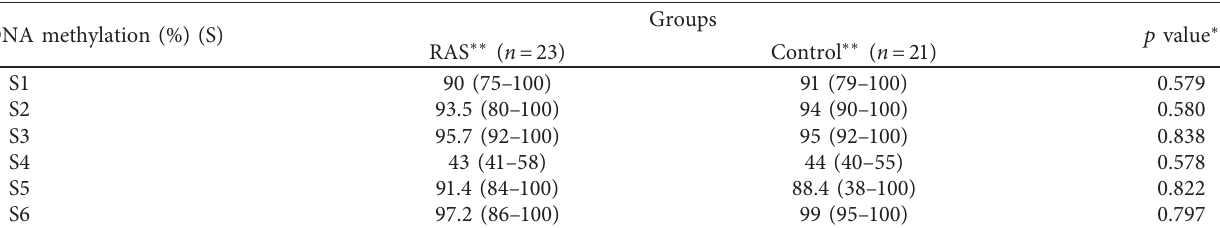
Figure 3: (a) Percentage of methylation in CpG site 1. (b) Percentage of methylation in CpG site 2. (c) Percentage of methylation in CpG site 3. (d) Percentage of methylation in CpG site 4. (e) Percentage of methylation in CpG site 5. (f) Percentage of methylation in CpG site 6. (g) Pyrosequencing of DNA Methylation in the 6 CpG island IL6 promoter of an RAS patient. Table 3: Methylation DNA in the RAS and control